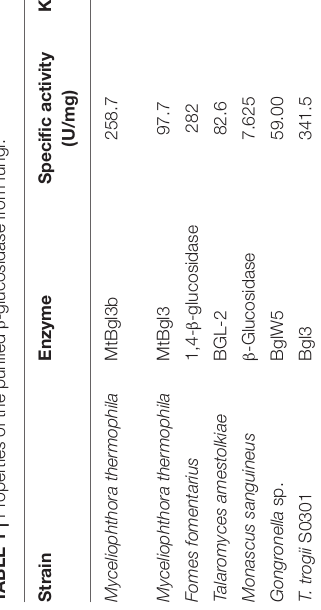
glycosides ( Figure 4 ). Based on HPLC analysis, the reaction system of phenolic glycosides produced new product peaks after TtBgl3 treatment ( Figure 5 ). Each compound was analyzed